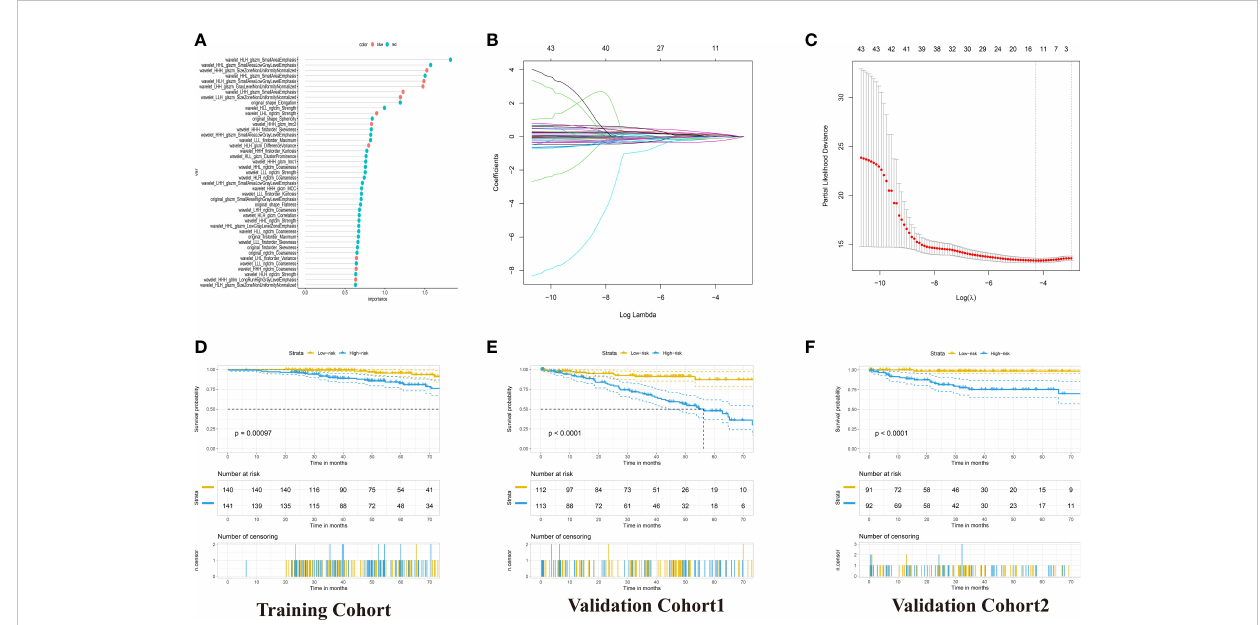
FIGURE 3 Development of the Radiomics Signature for OS Prediction with Machine Learning. (A) 43 radiomics feature importance from random-forest models. (B) The 5-fold cross-validation for tuning parameter screening in the LASSO regression model. (C) LASSO coef fi cient pro fi les of the features at different lambda values. (D – F) Kaplan – Meier curves for patients with High- and Low-Radiomics Score in the training and two validation